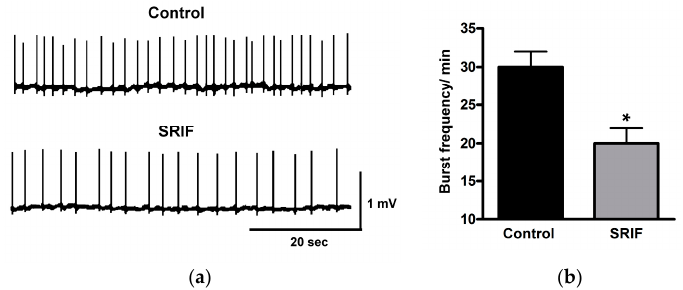
Figure 6. Somatostatin reduces the firing rate of mouse hippocampal neurons. Extracellular recordings with a sharp microelectrode were performed from the stratum pyramidale of the CA1 subfield in a tissue slice. ( a ) Spontaneous firing (Control) was induced by perfusing tissue with Mg 2+ -free medium containing the potassium channel blocker 4-AP. Application of 1 µM somatostatin (SRIF) reduced the firing rate. ( b ) Quantitative analysis for the somatostatin effect shown in ( a ). Somatostatin produced a decrease of ~30% in the frequency of action potentials. * p < 0.05. Modified from [114].